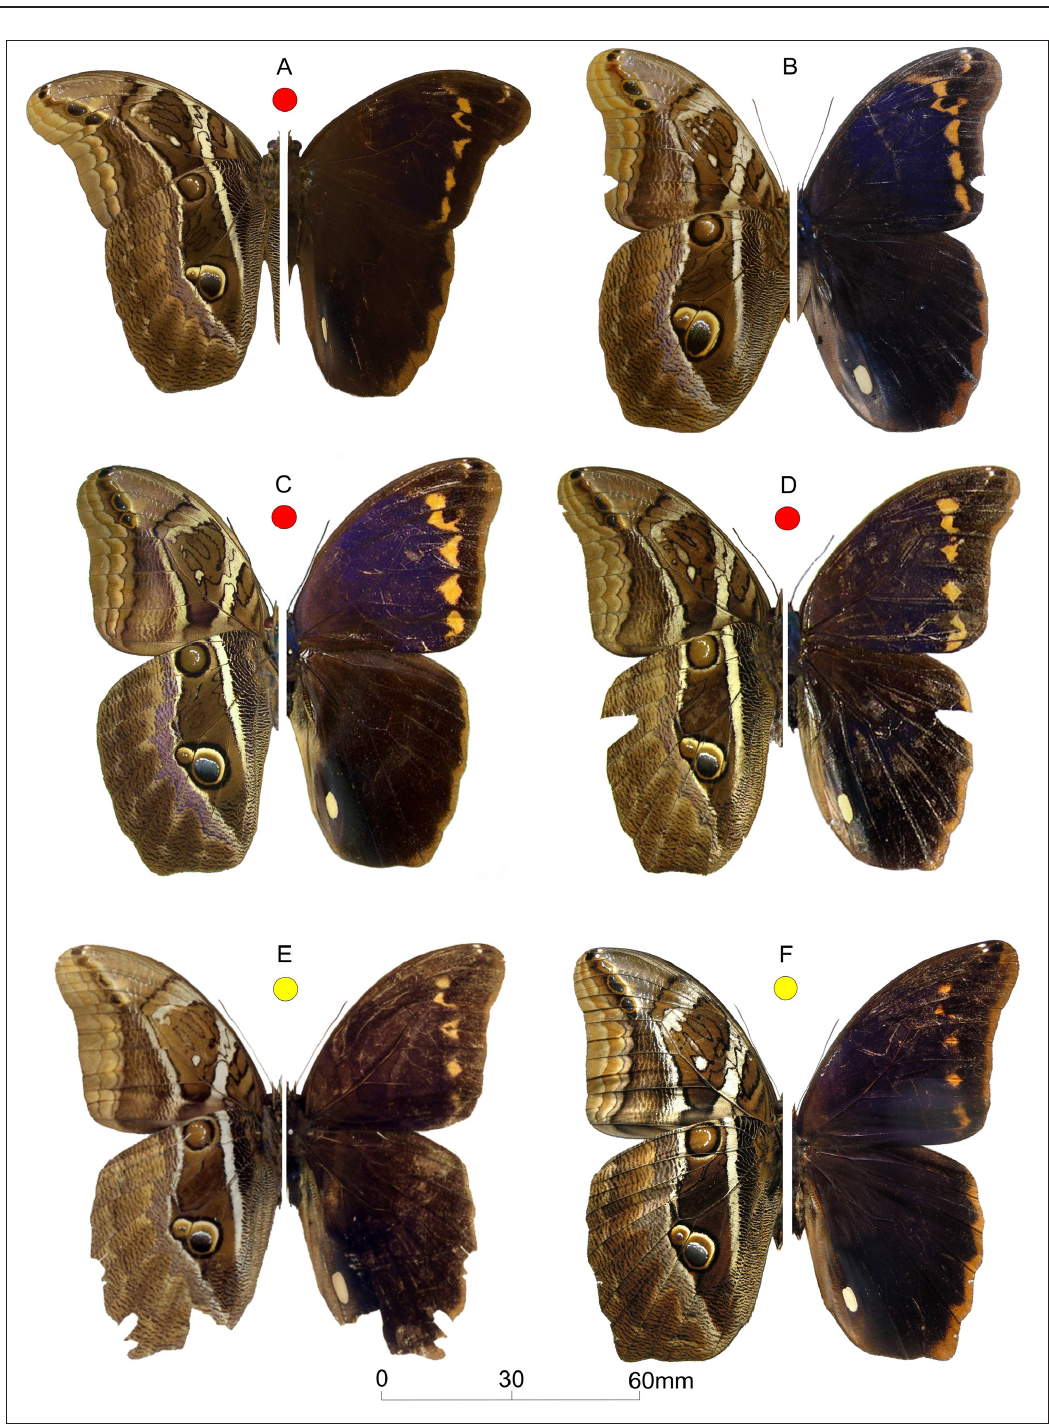
Fig. 4. Habitus of males. Red spot: holotype (HT) or lectotype (LT). Yellow spot: syntype (ST) or paratype (PT). A . Eryphanis zolvizora zolvizora (Hewitson, 1877), LT (Bolivia; BMNH). B . The southernmost known specimen of E. z. zolvizora (Manchones, Santa Cruz, Bolivia; MHNC). C . Eryphanis zolvizora inca ssp. nov., HT (Aguas Calientes, Cuzco, Peru; MJP). D . Eryphanis zolvizora chachapoya ssp. nov., HT (Huamanpata, Amazonas, Peru; MJP). E . Eryphanis z. chachapoya ssp. nov., ST of Eryphanis opimus Staudinger, 1887, from Chanchamayo, Junín, Peru (BMNH). F . PT of E. z. chachapoya ssp. nov. with small spots (Alto Nieva, Amazonas, Peru; MNHN, PBGL